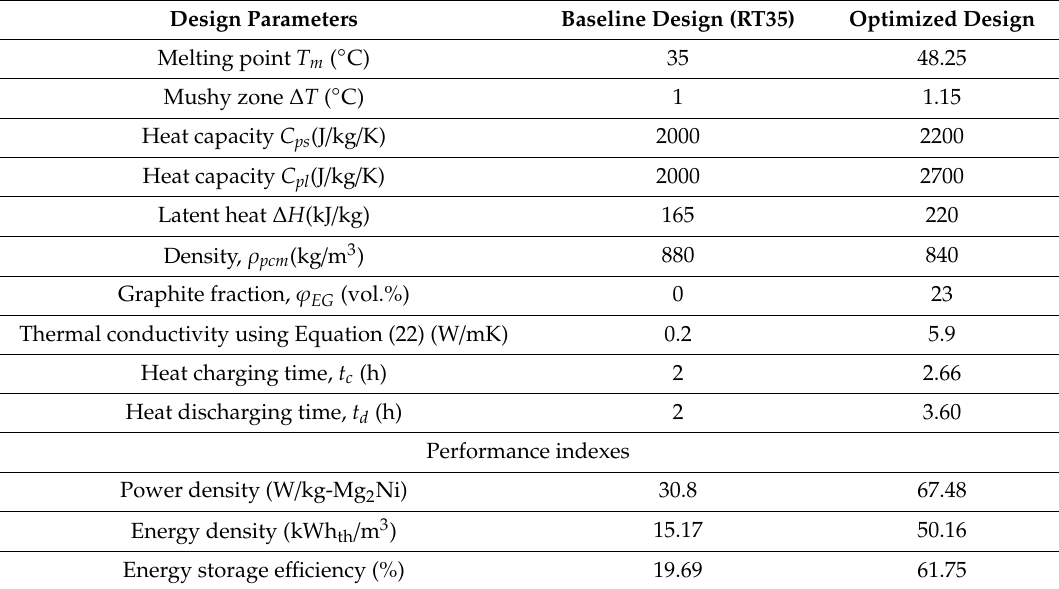
Table 4. Performance comparison between the baseline case and optimized